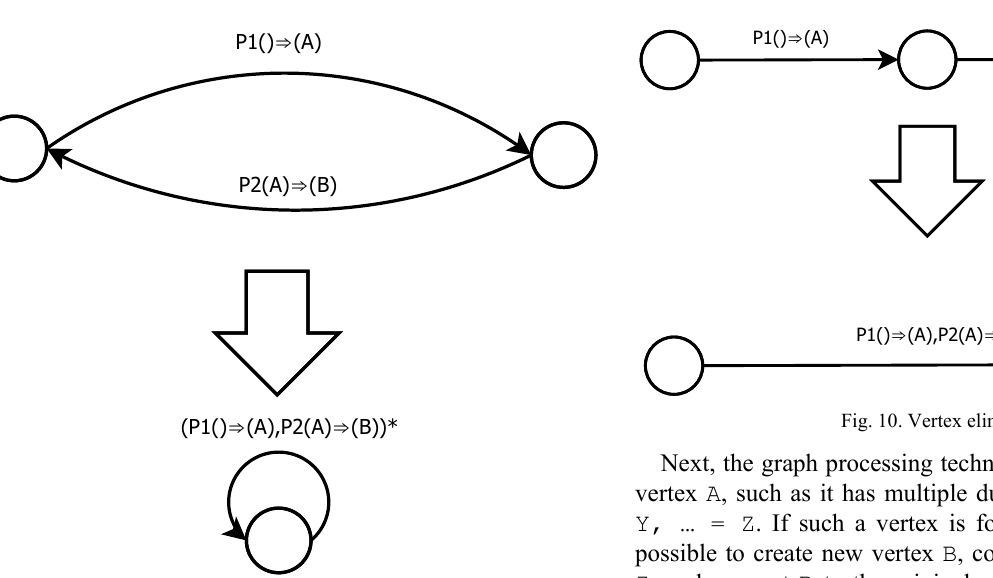
Fig. 8. Cycle elimination by vertex merging.